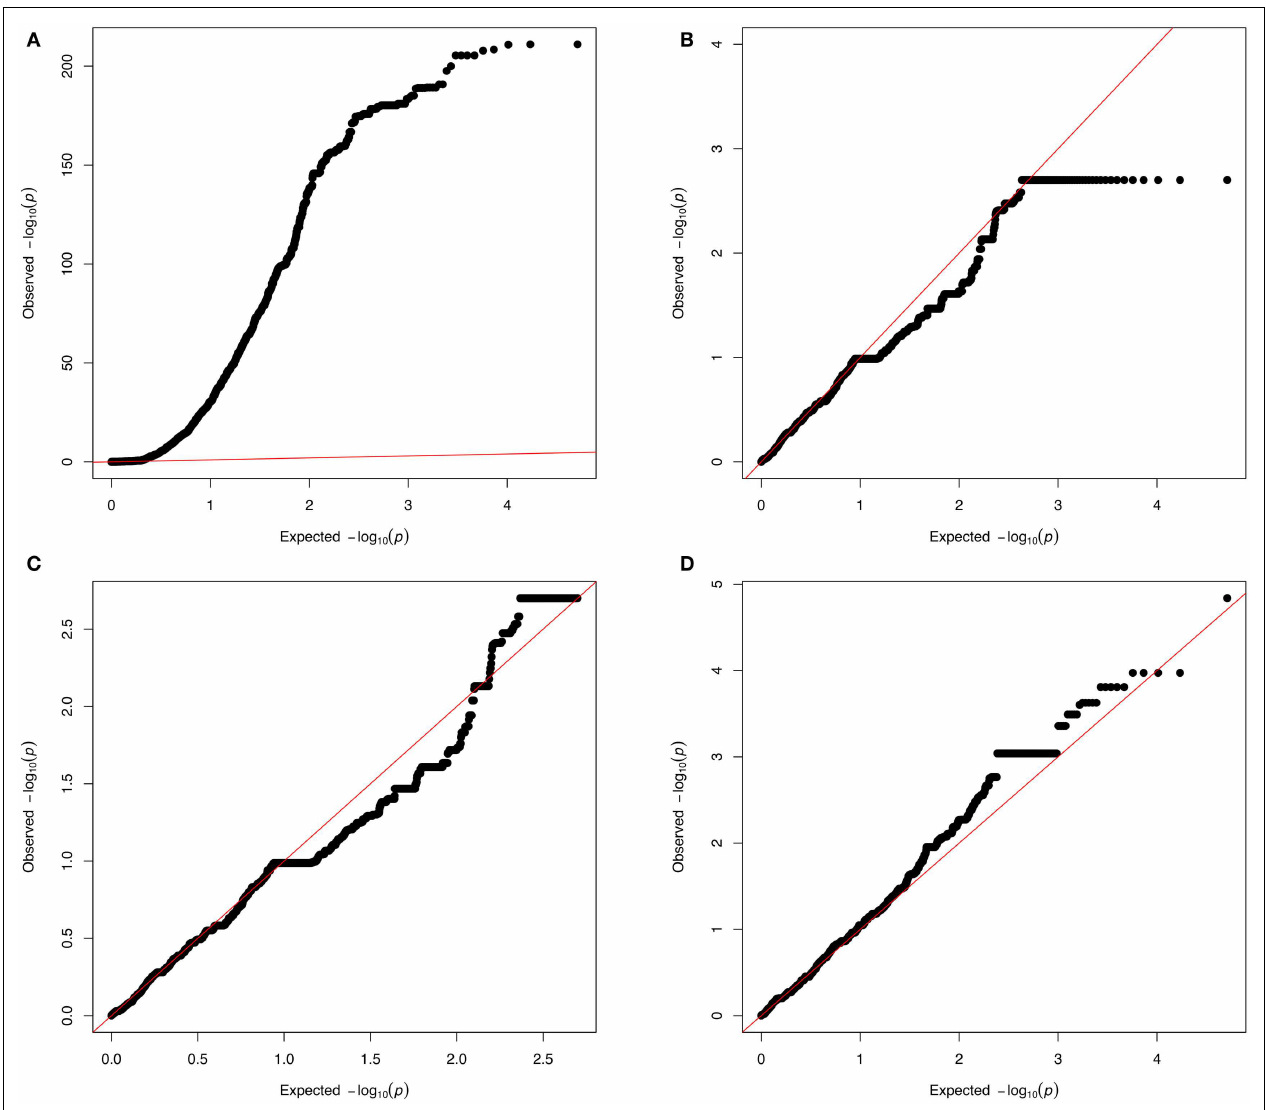
while many of these probes correspond to a same CNV region (thus the presented p -values are not from truly independent tests). (C) Shows a QQ plot adjusting for PC1 and where P 0 (the X axis) accounts for the fact that probes can come from the same CNV region. Such plot can be done (in the R programing language) by setting the vector of expected p -value ( X axis) as P 0 < − seq[1/ N ,1,by = (1 − 1/ N )/( n − 1)] where N is the number of CNV regions (number of effective tests) and n is the total number of CNV probes (number of observations). (D) Shows results from association with real data (here body mass index). In these QQ-plots, points with identical p -values correspond to rare, but rather long CNVs that produce multiple identical